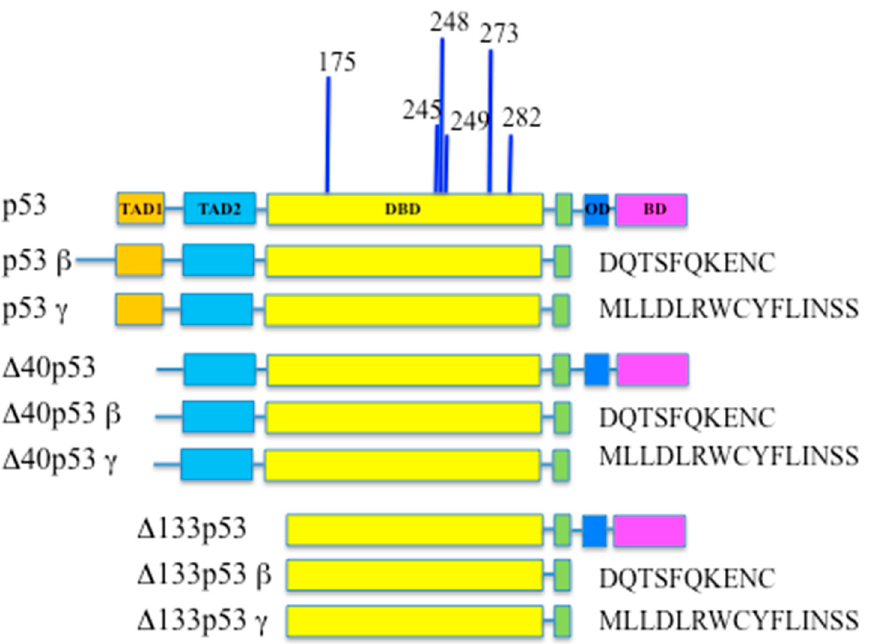
Figure 1. p53 tumor suppressor gene, its isoforms and functional domains: TAD1 = TransActivation Domain 1; TAD2 = TransActivation Domain 2; DBD = DNA Binding Domain; OD = Oligomerization Domain; BD = Basic Domain. The most common p53 hot spot mutation sites in cancer are